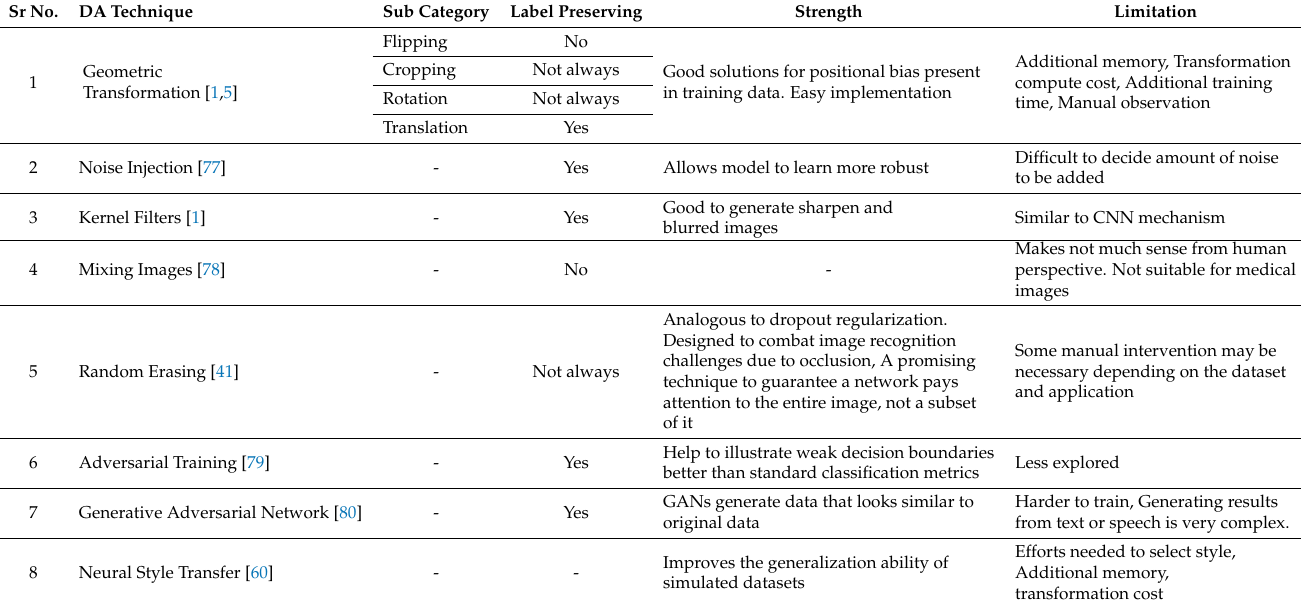
Table 1. Summary of basic and advanced image augmentation techniques.